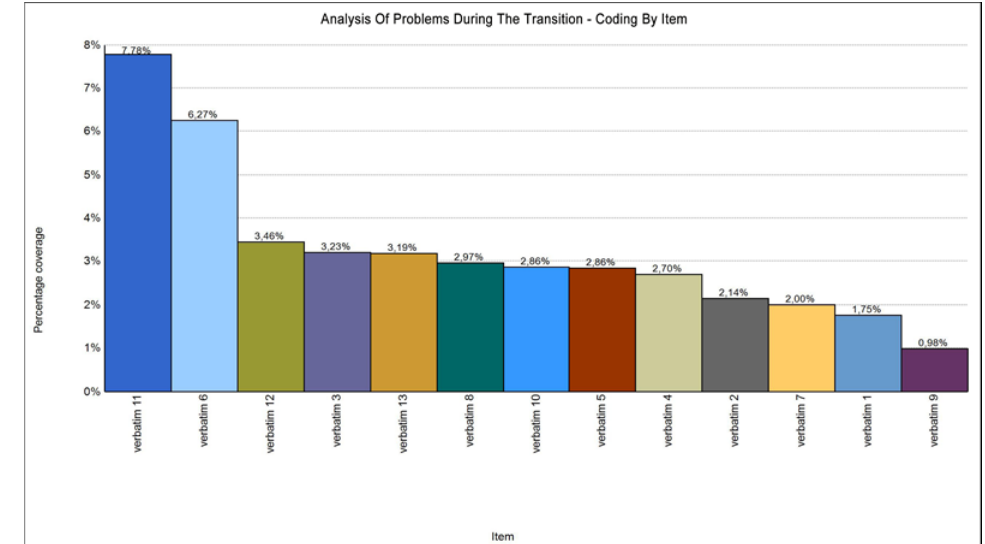
Fig. 10. Percentage of problems during the transition to